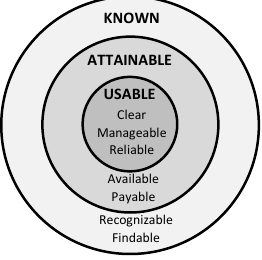
Figure 1. The Backx model and its’ three layers ATTAINALBE implies that the information can be obtained from a legal, physical and financial perspective. Legal